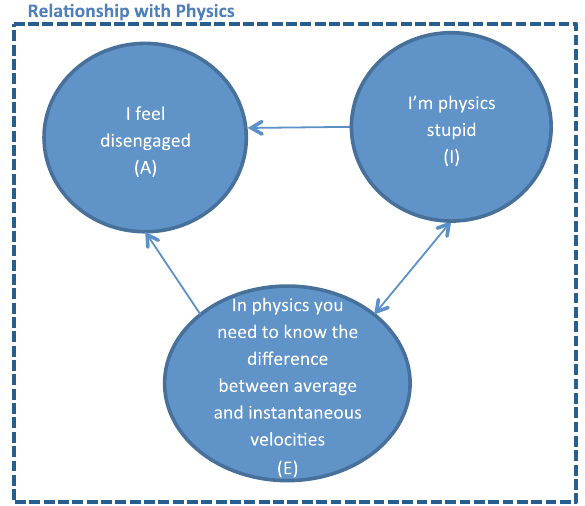
FIG. 4. A representation of the cascade of events that unfold in clip 4 in terms of affect, identity, and